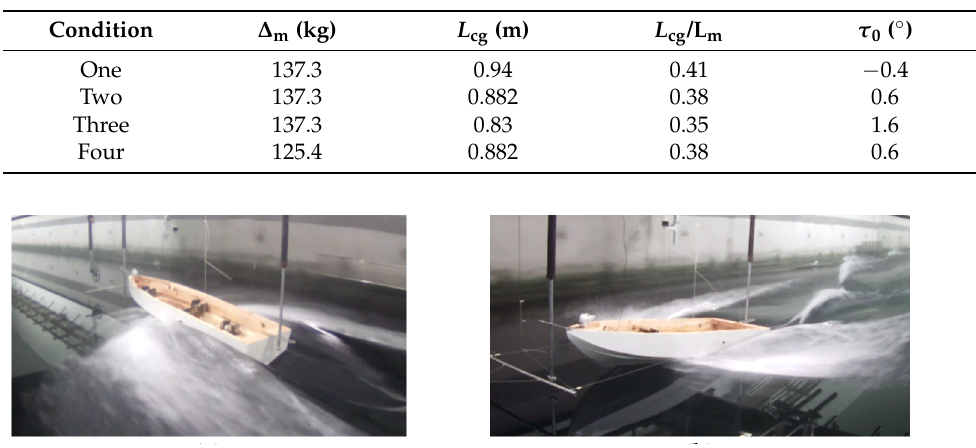
Table 2. Model test conditions in calm water.